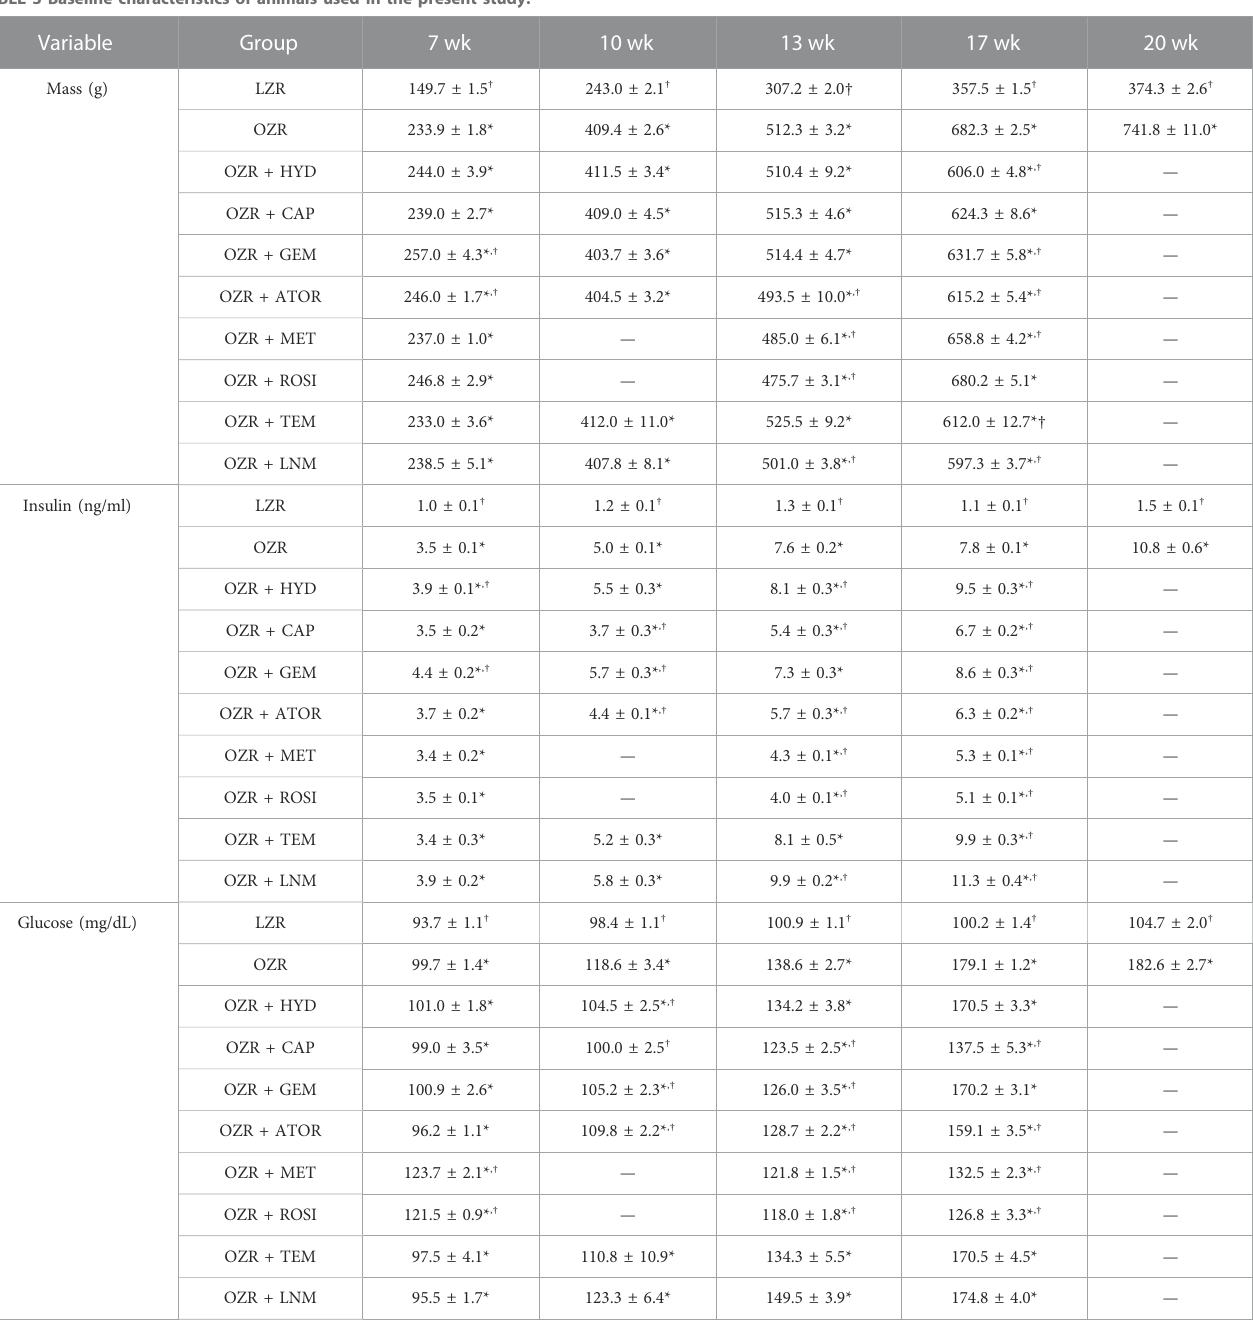
TABLE 3 Baseline characteristics of animals used in the present study. Variable